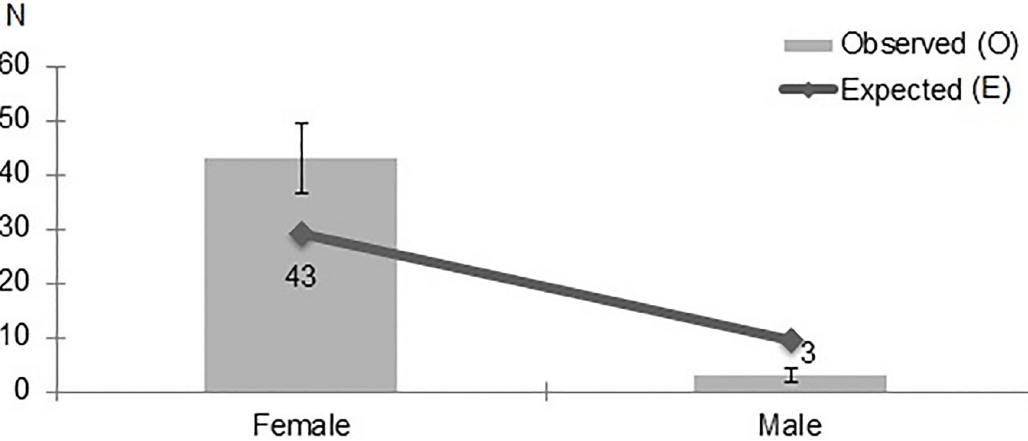
Fig 4. Gender distribution of JHS patients, as diagnosed with Sache’s